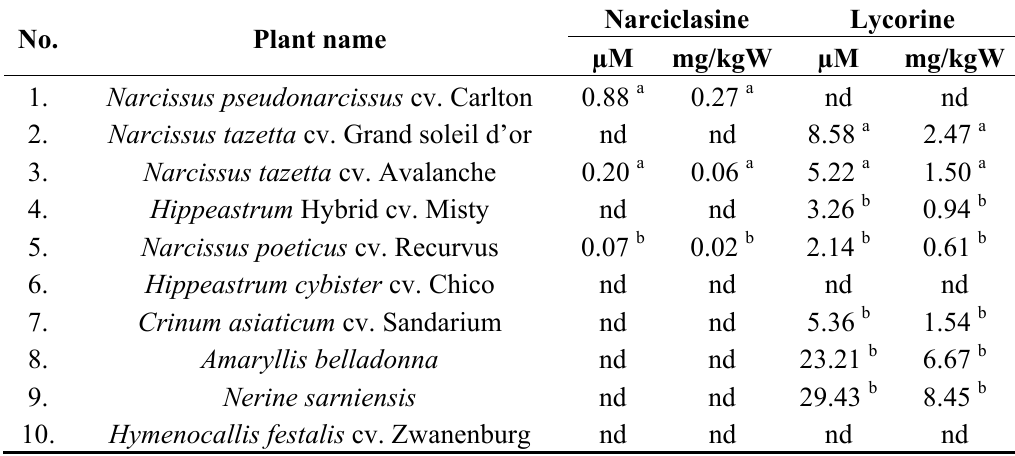
Table 3. Concentration of narciclasine and lycorine in ten flower bulb methanol extracts inhibiting germination of Senecio vulgaris seeds.